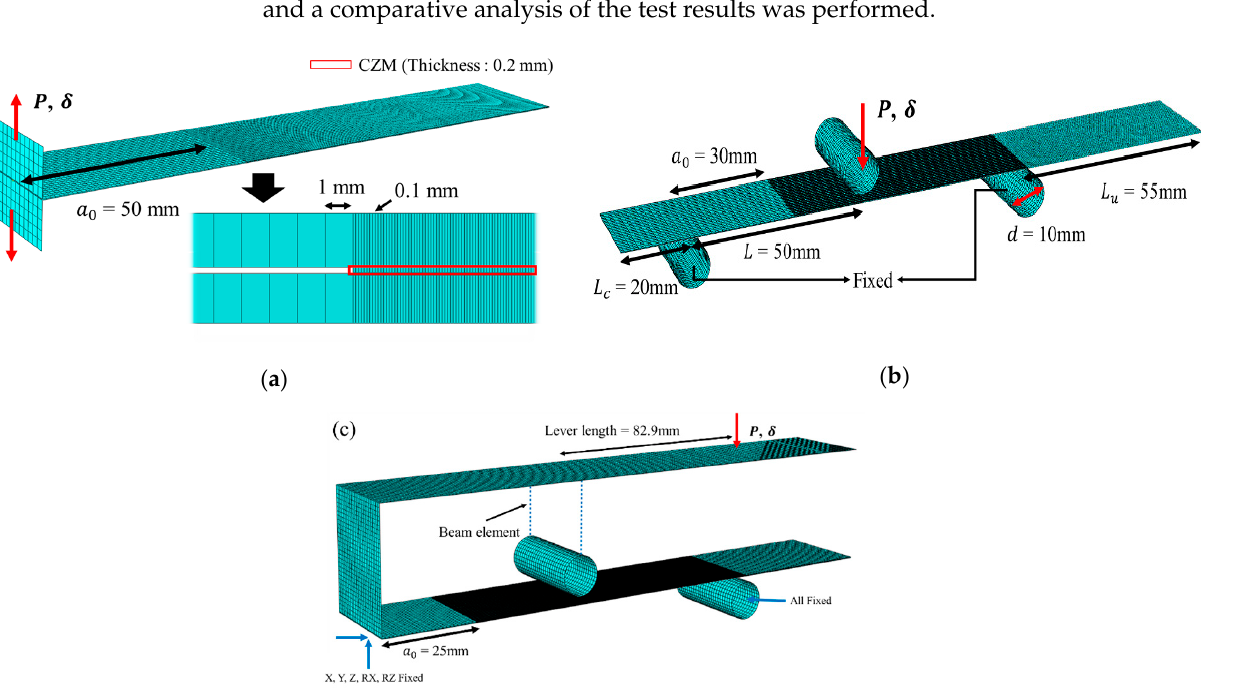
Figure 4. Finite element model of specimen: ( a ) Mode I, ( b ) Mode II, and ( c ) Mixed-mode. Table 1. Material properties of FM73.